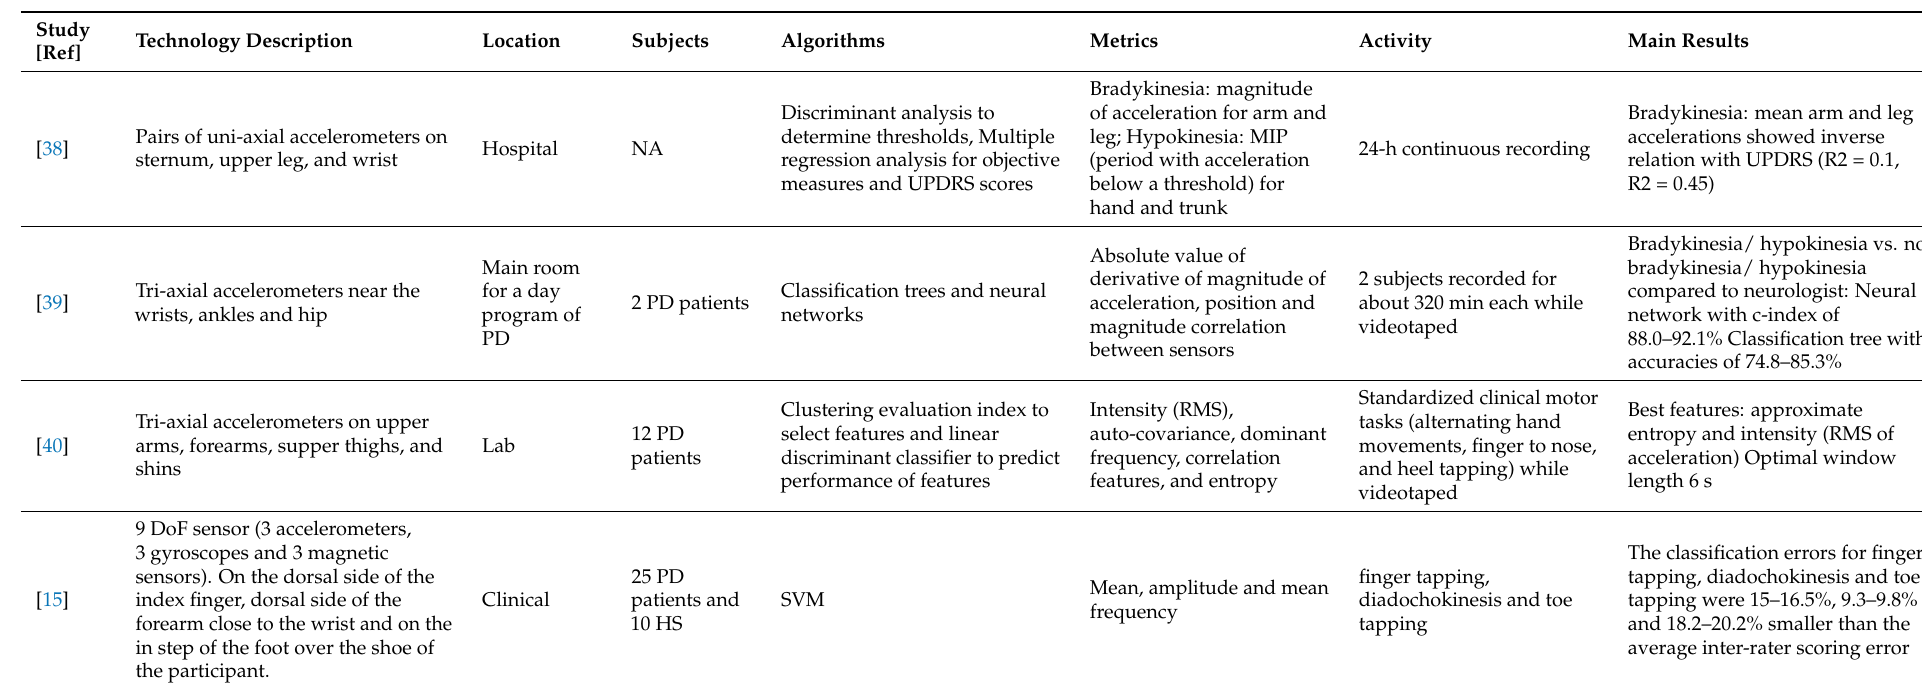
Table 3. Studies on